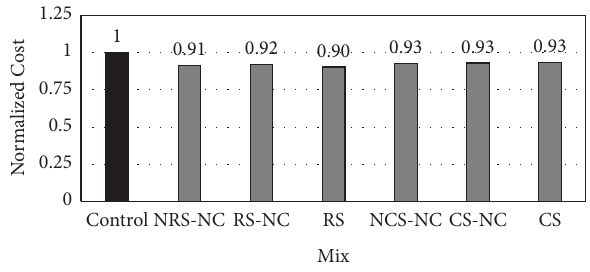
Figure 9: Normalized cost of 28 MPa concrete. Table 7: Performance indices for 28MPa